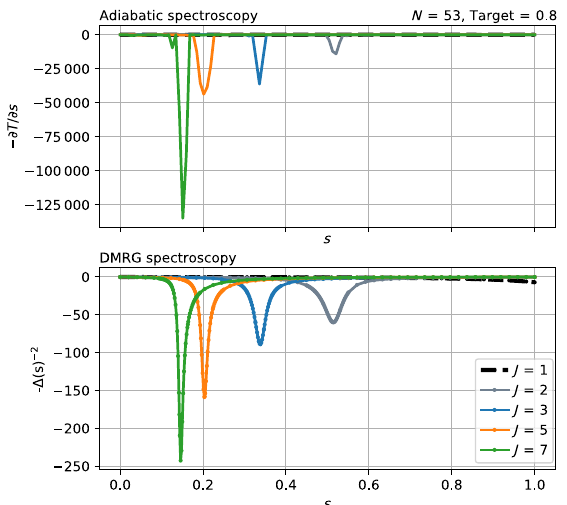
FIG. 1. Adiabatic spectroscopy for a chain of N = 53 qubits and a target ground-state fidelity of 0.7. For the Hamiltonian (cid:2) ( J σ z σ z + h σ x + g σ z ) , the adiabatic path is a H ( J , g , h ) = i i i i i + 1 linear interpolation from H ( 0, 1, 0 ) to H ( J , 1, 1 ) . The minima of the different curves correspond to the position and smallness of the respective spectral gaps. In the lower plot, − (cid:2)( s ) − 2 , obtained using density-matrix-renormalization-group (DMRG) methods, is shown as a comparison. The match with the Landau-Zener scaling is not exact, as higher-order corrections from adiabatic perturbation theory play a